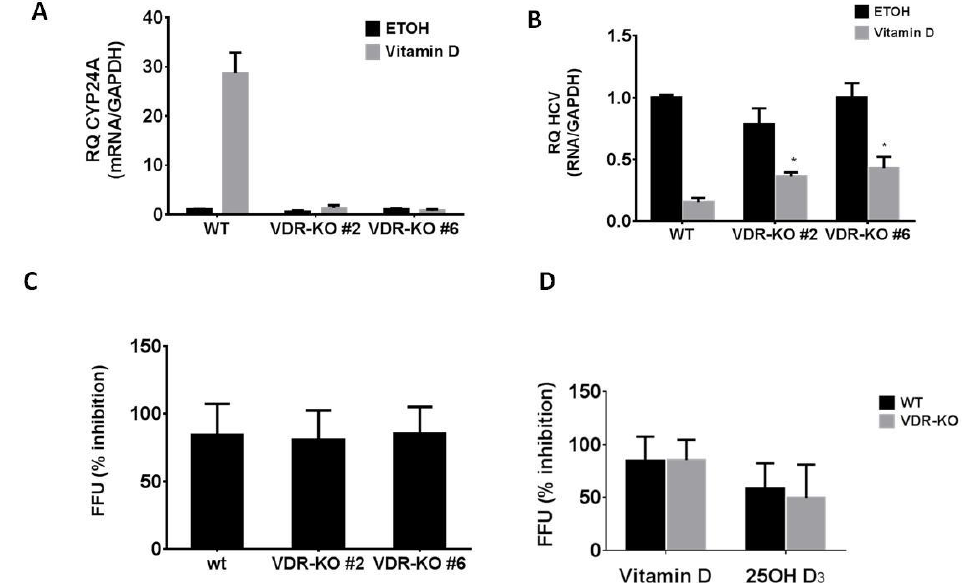
Figure 3. Vitamin D 3 and 25(OH)D 3 inhibit HCV production in a VDR-independent manner. ( A ) Real-time PCR analysis of Cyp24A1 mRNA expression levels in Huh7.5 wild-type (WT) and VDR knockout (VDR-KO) cells after 24 h treatment with vitamin D 3 (5 µ M) compared with nontreated cells. Results are presented as relative quantity (RQ) of the target gene mRNA normalized to Gapdh mRNA values; control cells mRNA levels were assigned a value of 1. ( B ) Real-time PCR analysis of HCV RNA expression levels in Huh7.5 WT and VDR-KO cells 24 h post-infection with HCV and treatment with vitamin D 3 (5 µ M) compared with nontreated cells. The results shown are the average of three independent experiments and presented as the relative quantity of the HCV noncoding region normalized to Gapdh mRNA values; the control cells were assigned a value of 1. ( C ) Inhibition of HCV HJ3-5 virus production by vitamin D 3 determined by FFU assay of virus released into media following infection of Huh7.5 and VDR-KO cells. ( D ) Inhibition of HCV HJ3-5 virus production by 25(OH)D 3 determined by FFU assay of virus released into media following infection of Huh7.5 and VDR-KO #6 cells. The results shown are the average of three independent experiments. Statistical significance